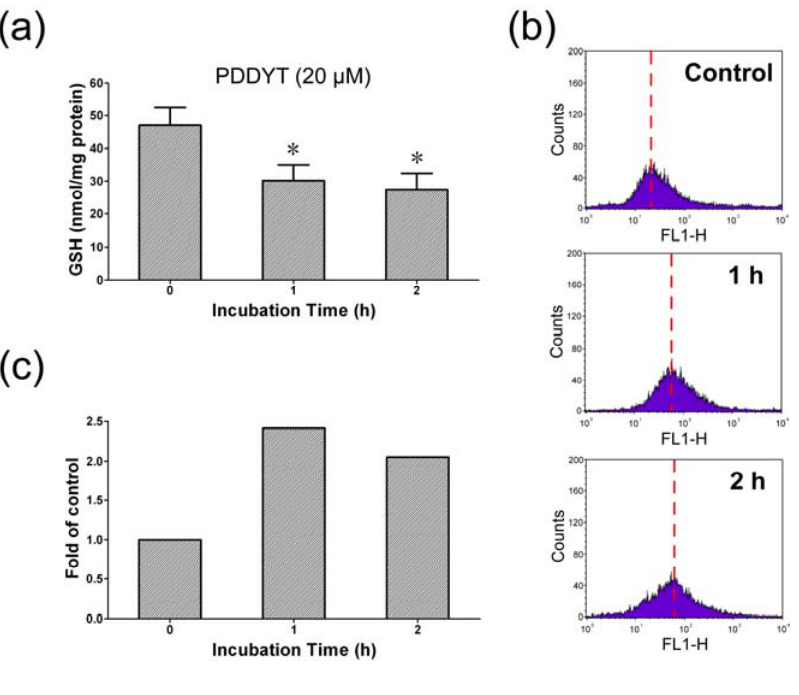
Figure 5. PDDYT mediated the depletion of the cellular GSH. (a) Cellular GSH levels after Hepa 1c1c7 cells were exposed to 20 μ M PDDYT for 1 and 2 h. *, treatment groups were significantly different from the control group (P < 0.05) using Student’s t test, with n = 3. (b) The ROS generation after Hepa 1c1c7 cells treated with 20 μ M PDDYT for 1 or 2 h. (c) Quantification of ROS generation after treatment with PDDYT for 1 and 2